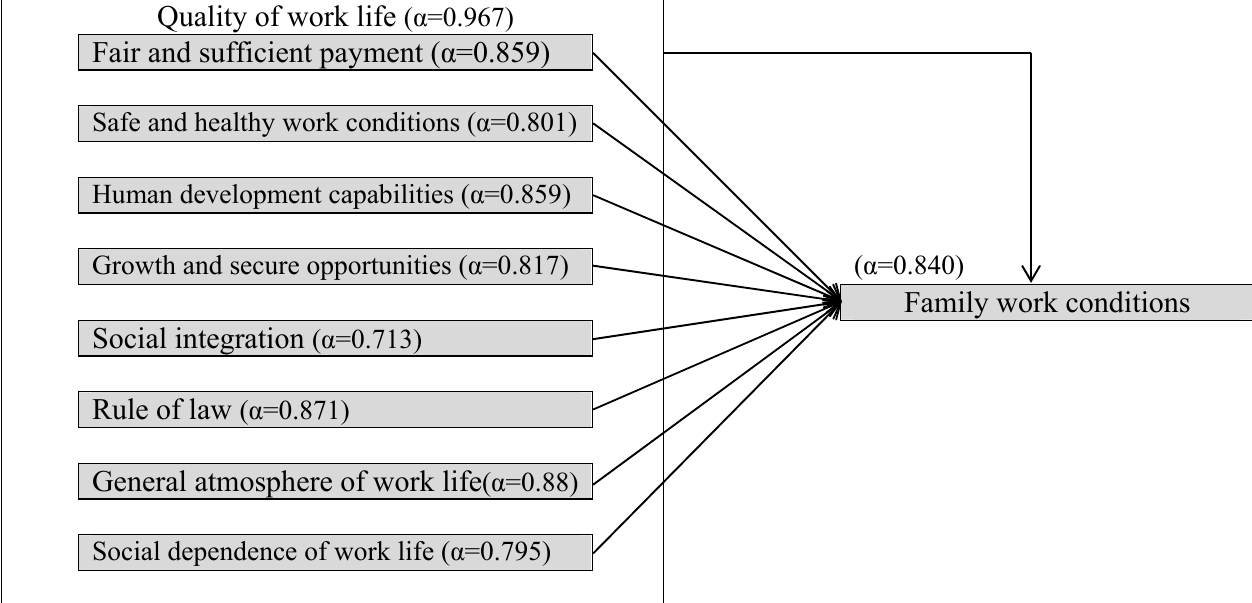
Fig. 1. The structure of the proposed